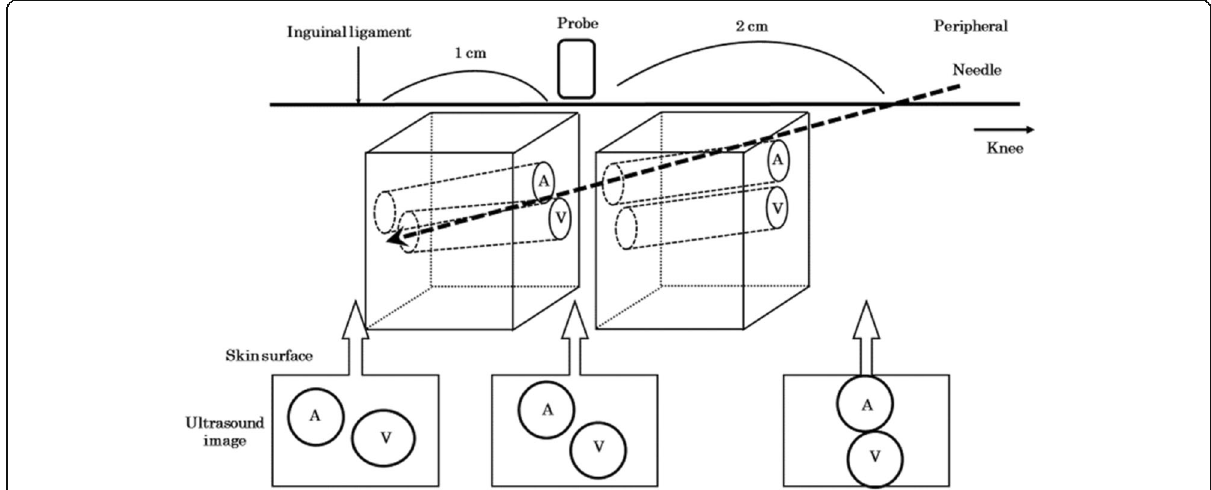
Fig. 1 Scheme illustration of the relationship between the needle and ultrasound image. The femoral artery and femoral vein did not overlap at the inguinal ligament level. However, both vessels overlapped toward the periphery. The figures below are ultrasound images at each point. A femoral artery, V femoral vein